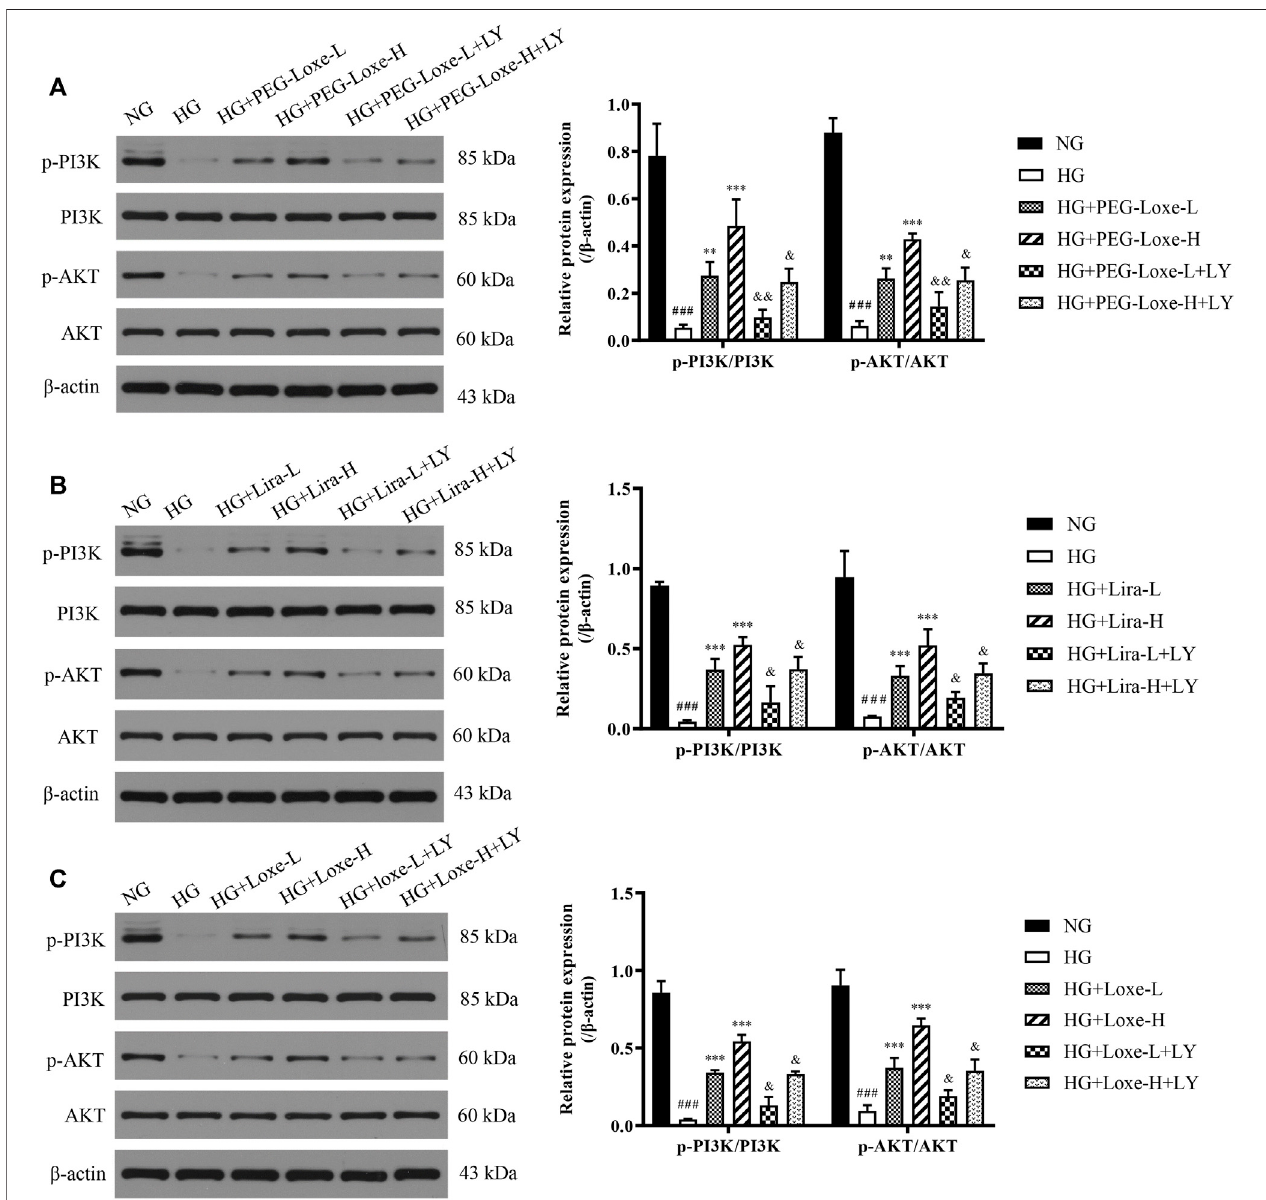
FIGURE7| Theexpressionsofphospho-phosphoinositol3kinase(p-PI3K),PI3K, phospho-proteinkinaseB(p-AKT),andAKTinHepG2cellstreatedwithnormal glucose(NG),highglucose(HG),HG+PEG-Loxe,HG+PEG-Loxe +LY(PI3Kinhibitor),HG+Lira, HG+Lira +LY,HG+Loxe,andHG+Loxe+LY.Proteinexpression levels were normalized to the levels of β -actin. Data are presented as the mean ± SD; n (cid:2) 3; ### p < 0.001 compared to the NG group; ** p < 0.01 and *** p < 0.001 compared to the HG group; & p < 0.05 and && p < 0.01 compared to the HG + PEG-Loxe/HG + Lira/HG + Loxe group.